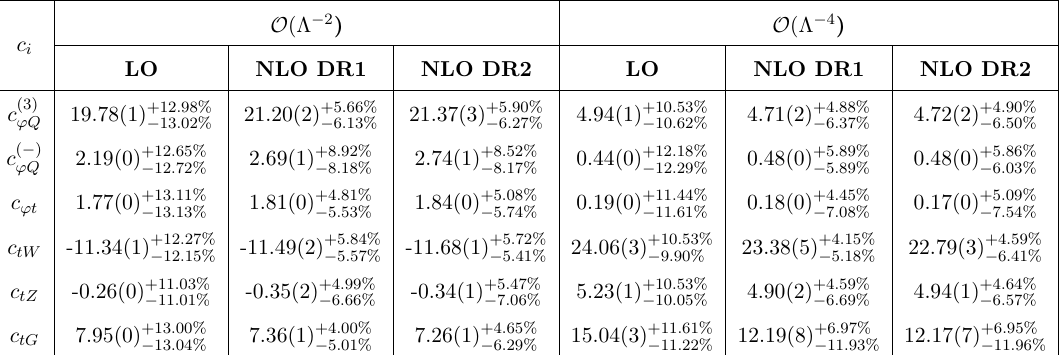
Table 3 . The SMEFT contributions [fb] to inclusive tWZ production, at linear and quadratic levels, LO and NLO, including QCD scale uncertainties, for the LHC These results are for DR1 and DR2 predictions when applying a veto on b -quarks with | η | < 2 . 5 or p T > 30